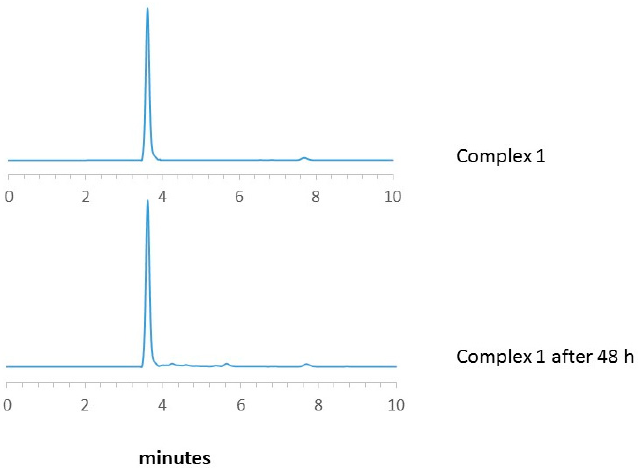
Figure 1. HPLC chromatograms of complex 1 in DMSO/PBS (1/10) at 37 °C.